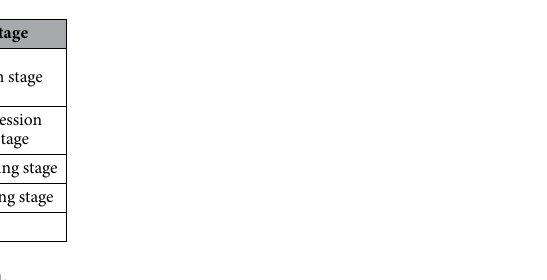
Table 1. Stratigraphic chart in XJWZ